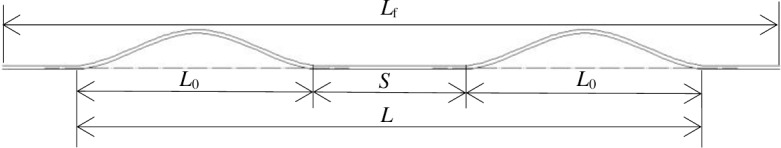
Feature parameters for a pipeline with two nearby imperfections.